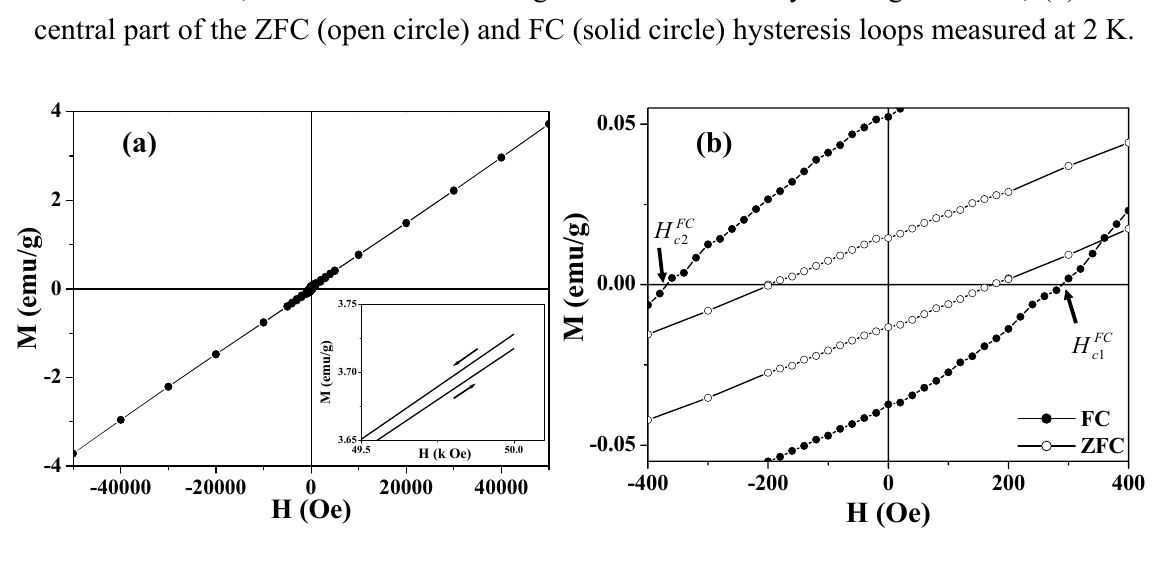
O hollow spheres. (a) The FC hysteresis loop 3 4